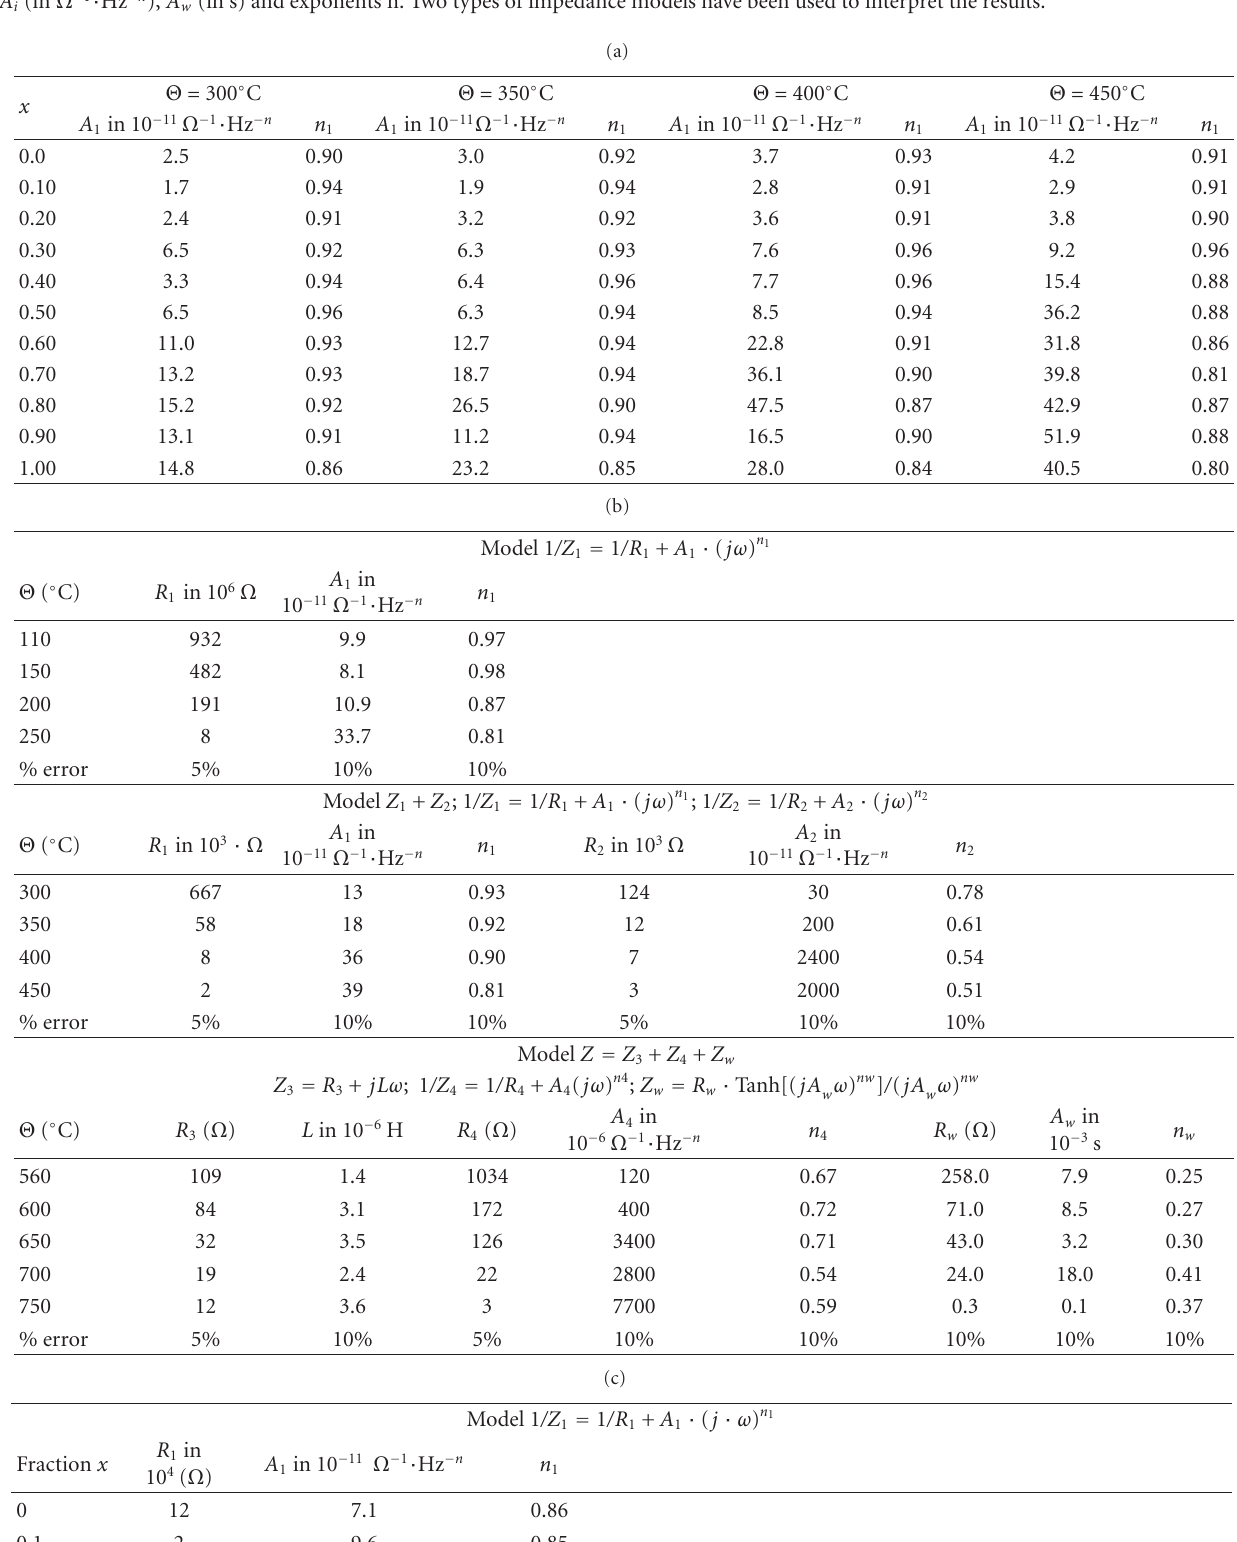
Table 2: (a) Electrical characteristics of compacted samples: CPE terms A 1 (in Ω − 1 · Hz − n unit) and CPE exponents n , as a function of composition and for various temperatures Θ ≤ 450 ◦ C; 10% error for A 1 and n parameters. (b) Modeling parameters for x = 0 . 7 sample as a function of temperature Θ : resistances R i (in Ω ), CPE terms A i (in Ω − 1 · Hz − n ), A w (in s) and exponents n . Three types of impedance models have been used to interpret the results. (c) Modeling parameters as a function of composition x , at 700 ◦ C: resistances R i (in Ω ), CPE terms